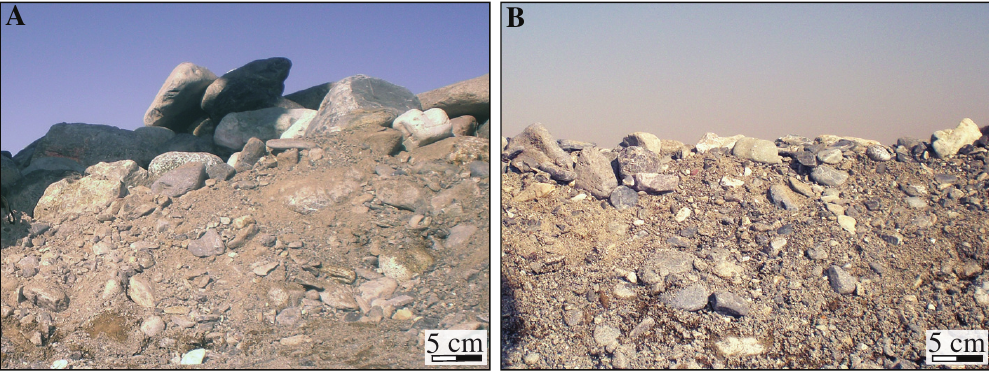
Fig. 7. View of a wall of trenches dug in (a) a chute and (b) a bar. The chute is clearly made up of one coarse layer with no vertical extension, whereas the bar deposits are more homogeneous in